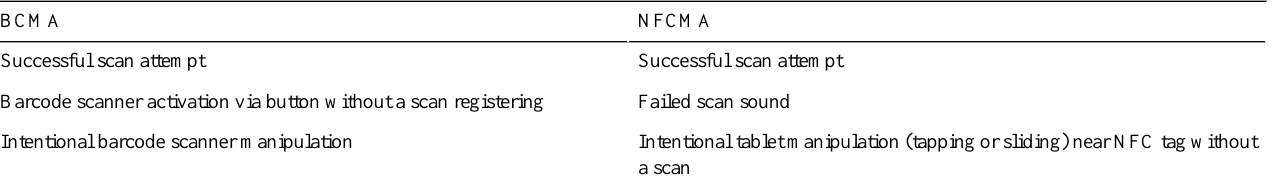
Table 1. Scanning attempt criteria for barcode-enabled medication administration (BCMA) and near field communication-enabled medication administration (NFCMA) systems.